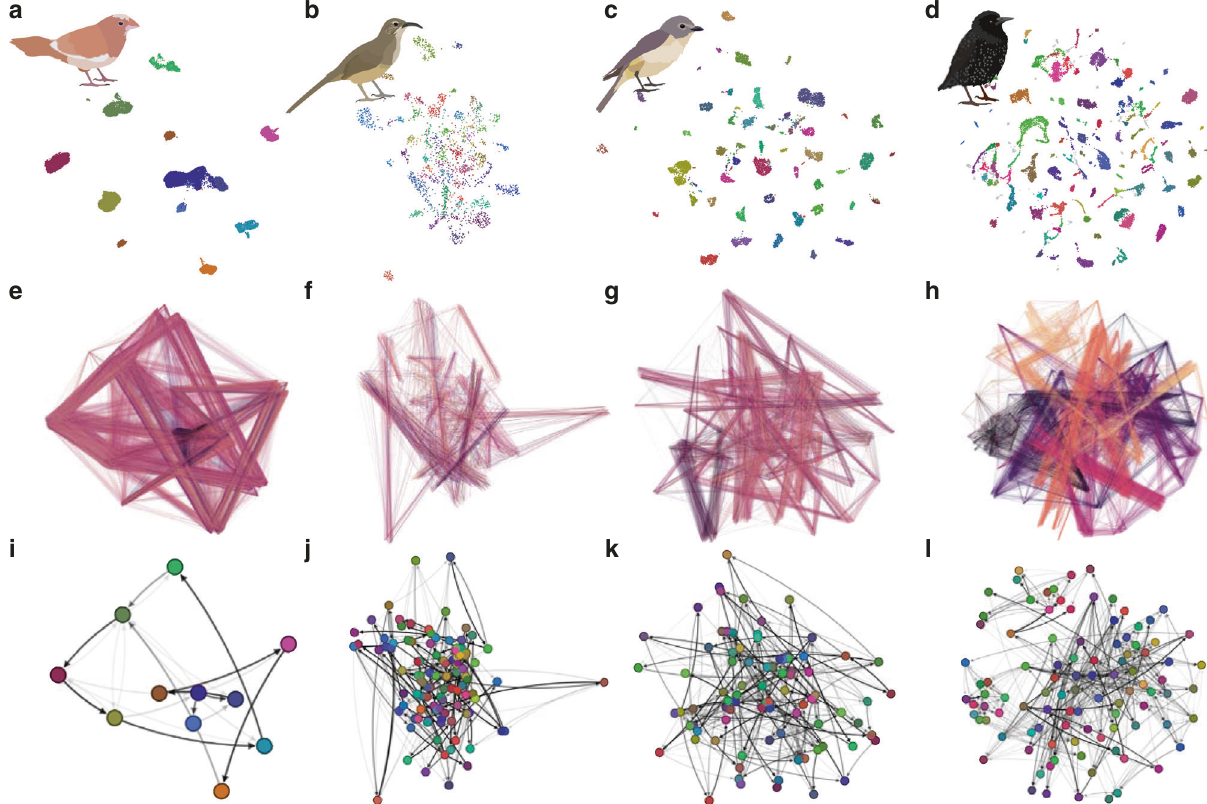
Fig. 1 Latent and graphical representations of songbird vocalizations. a – d show UMAP 41 reduced spectrographic representations of syllables from the songs of single birds projected into two-dimensions. Each point in the scatterplot represents a single syllable, where color is the syllable category. Syllable categories for Bengalese fi nch ( a ), California thrasher ( b ), and Cassin ’ s vireo ( c ) are hand-labeled. European starlings ( d ) are labeled using a hierarchical density-based clustering algorithm 67 . Each column in the fi gure corresponds to the same animal. Transitions between syllables ( e – h ) in the same 2D space as a – d , where color represents the temporal position of a transition in a song and stronger hues show transitions that occur at the same position; weaker hues indicate syllable transitions that occur in multiple positions. Transitions between syllable categories ( i – l ), where colored circles represents a state or category corresponding to the scatterplots in a – d , and lines represent state transitions with opacity increasing in proportion to transition probability. For clarity, low-probability transitions ( ≤ 5%) are not